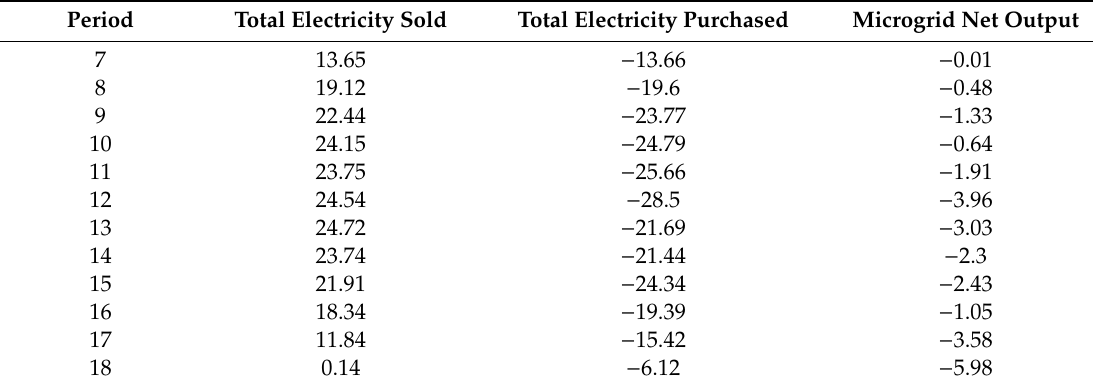
Table 11. Total electricity sold and total electricity purchased (kW ·